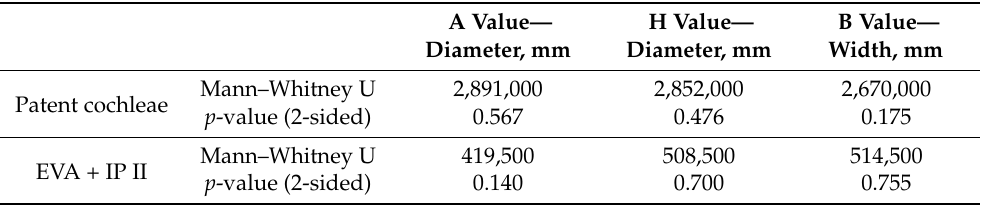
Table 3. Comparison of the cochlear parameters between males and females in the group with patent cochleae and EVA with IP